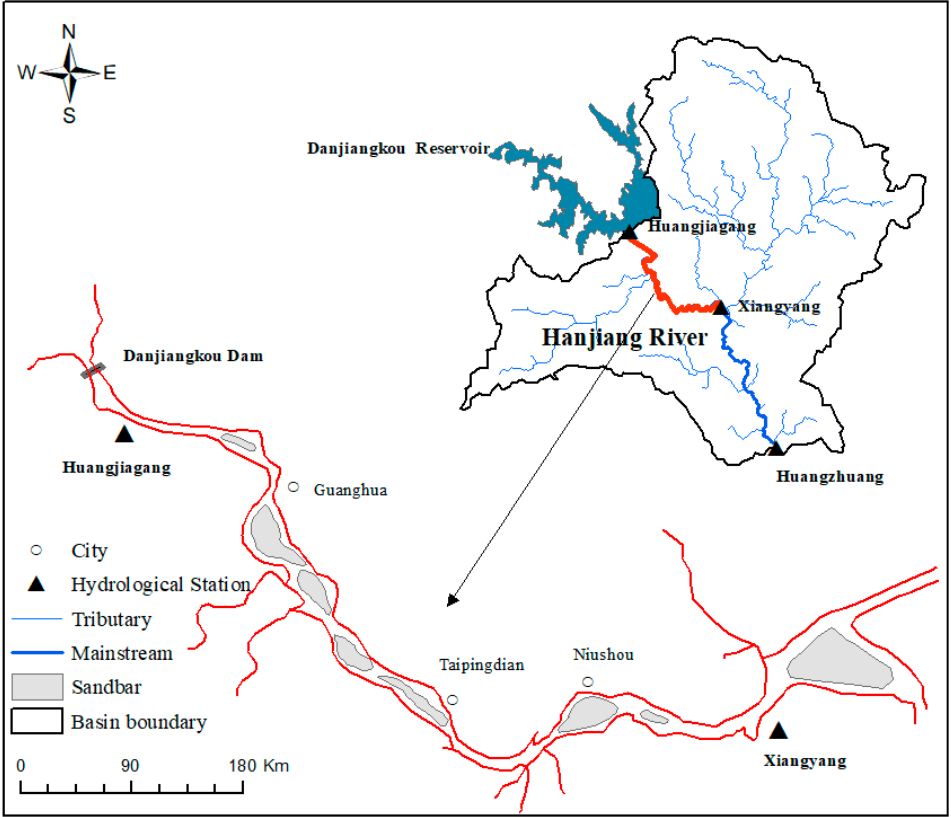
Figure 2. Sketch map of middle-Hanjiang River and studied river reach.